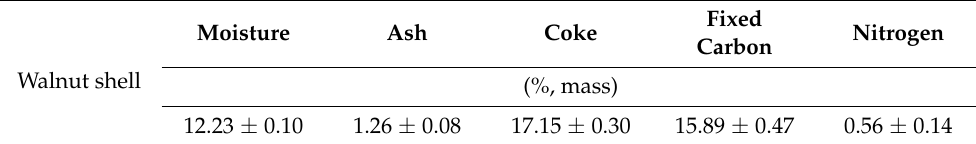
Table 1. Non-combustible matter content in the walnut shell.